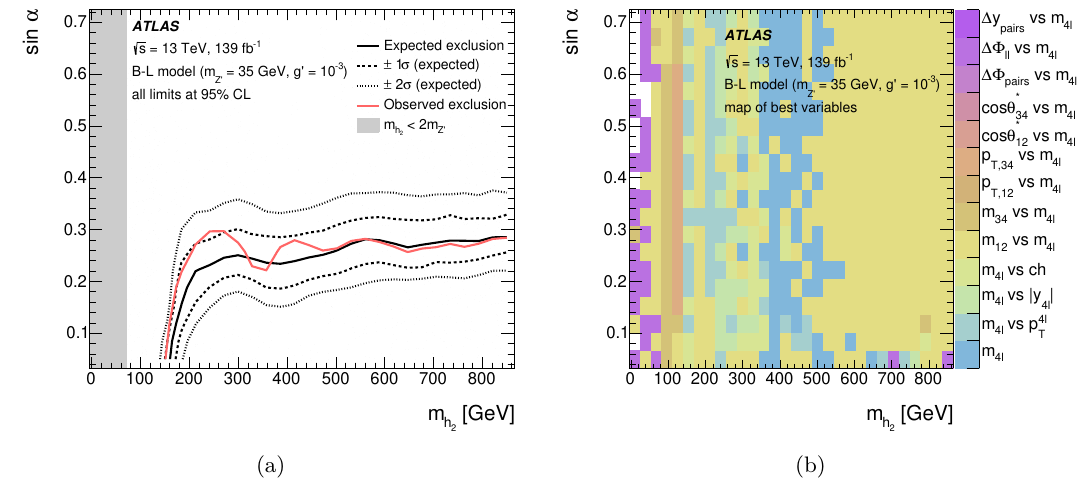
Figure 13 . (a) Exclusion contour at 95% confidence level for the B − L gauge model [104] in the plane of sin α versus m for m = 35 GeV and g 0 = 10 − 3 . The red line shows the observed exclu- h 2 Z 0 sion and the solid black line shows the expected exclusion, with the dashed black lines indicating the ± 1 σ and ± 2 σ uncertainty bands. The region above and to the left of the lines is excluded, up to the grey band, which shows the region m 2 m , where the four-lepton final state has no h 2 < Z 0 sensitivity. (b) Colour palette indicating which observable has the highest expected sensitivity at each point in the parameter space and is used to set the